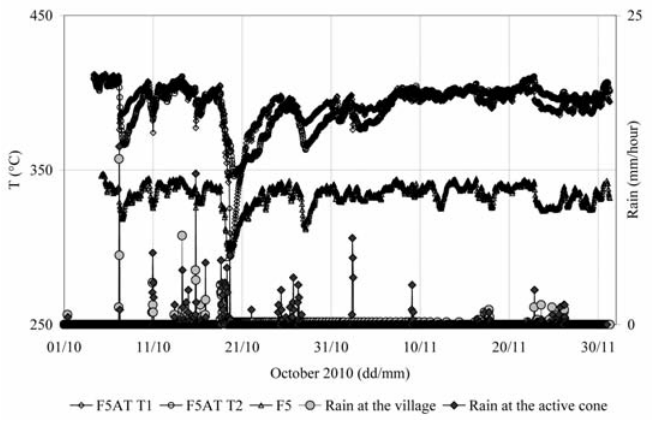
Figure 3. Short-term effects of rainfall on the fumarole temperatures. Continuous monitoring data from the fumaroles on the northern edge of the crater and rain recorded at the village of Vulcano Porto and at the top of the